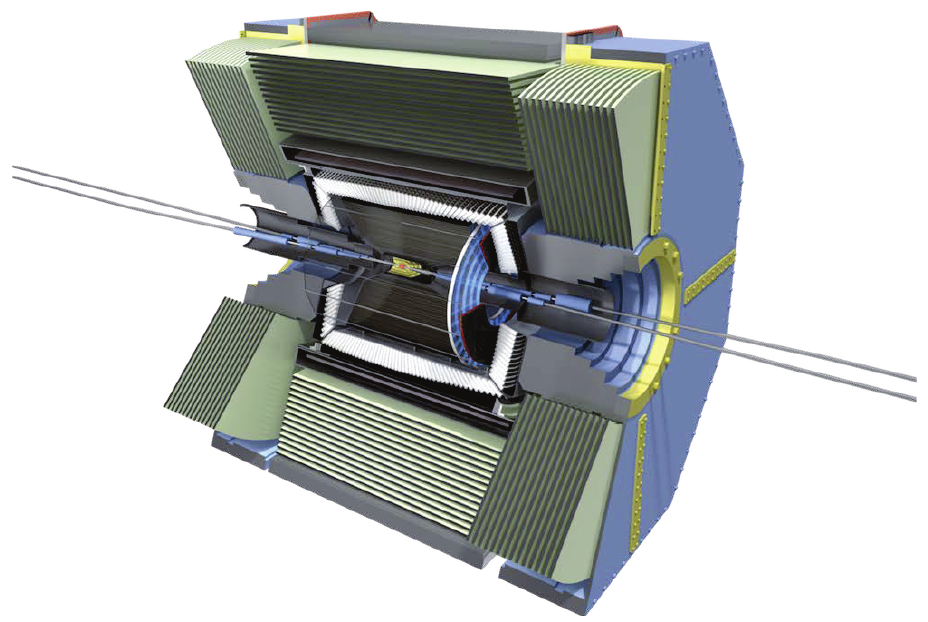
Figure 1. The Belle II